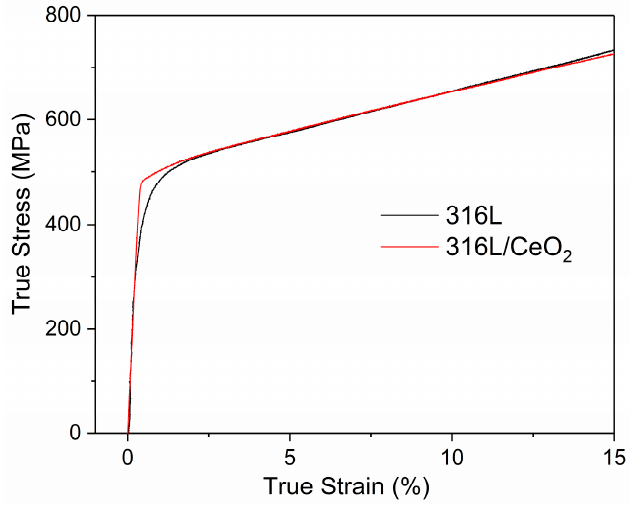
Figure 8. Room-temperature compressive stress–strain curves for the unreinforced SLM 316L specimen synthesized at 688 mm/s and SLM 316L/CeO 2 composite processed at 488 mm/s.